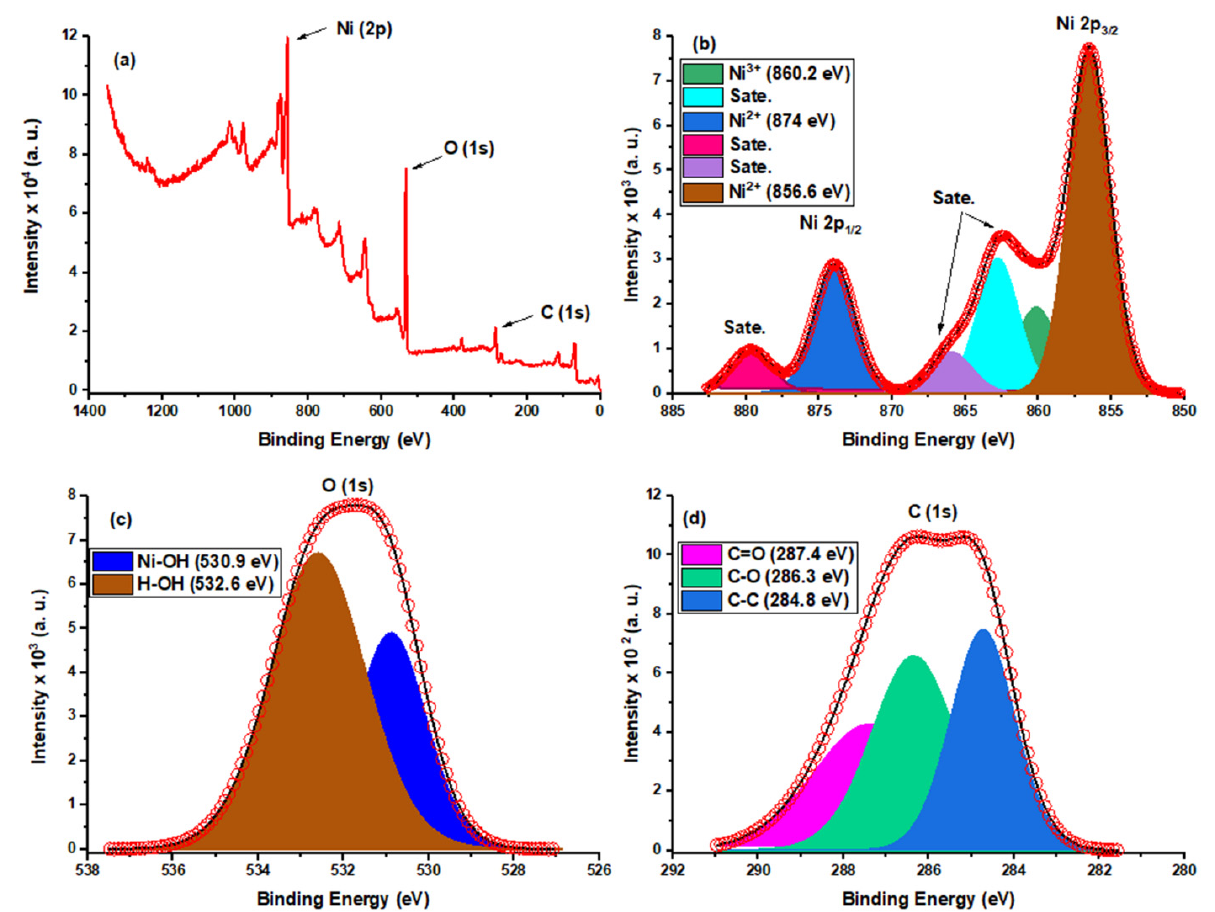
Figure 5. X-ray photoelectron ( a ) Survey scan ( b ) Ni (2p) ( c ) O (1s) and ( d ) C (1s) spectra for the synthesized β -Ni(OH) 2 nanocluster. Table 1. Binding energy (eV), FWHM, and atomic percentage for the synthesized β -Ni(OH) 2 .